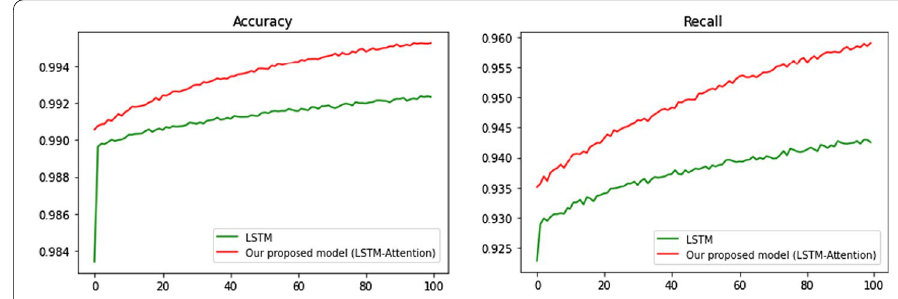
Fig. 11 Accuracy and Recall plots for compared models